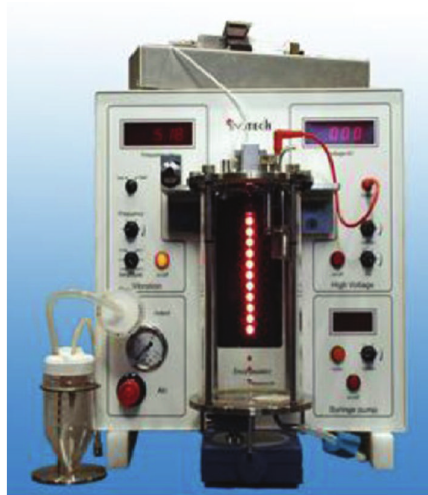
Figure 1: Encapsulator for making uniform gel